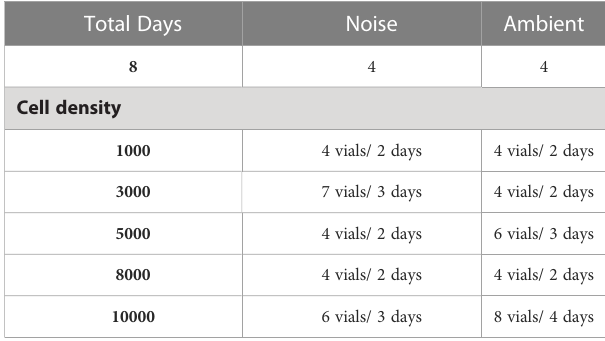
TABLE 2 Overview experimental grazer vials per day and sound